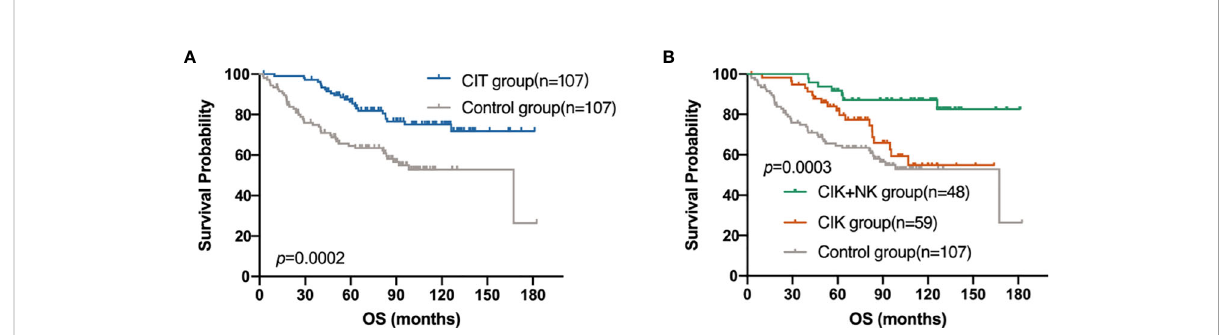
FIGURE 4 Kaplan – Meier estimates of overall survival (OS) of patients with postoperative breast cancer by different treatment groups. (A) OS curve of patients in CIT group (n = 107) versus the control group (n = 107). (B) OS curve of patients in CIK+NK group (n = 48), CIK group (n = 59) and the control group (n = 107).